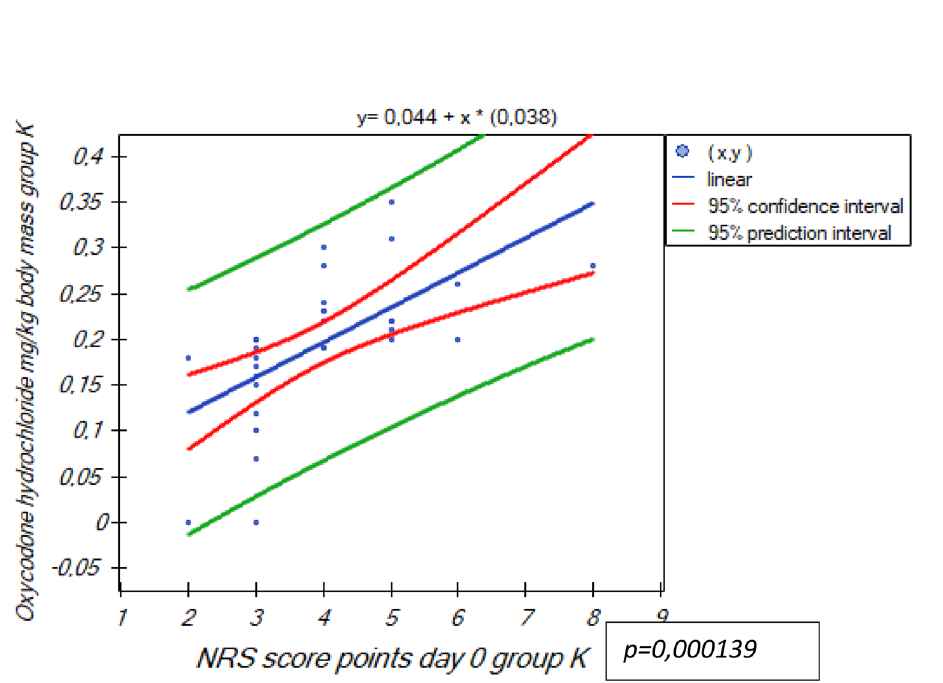
Figure 3. Linear correlation r-Pearson NRS points day 0 and oxycodone hydrochloride mg/kg body mass group